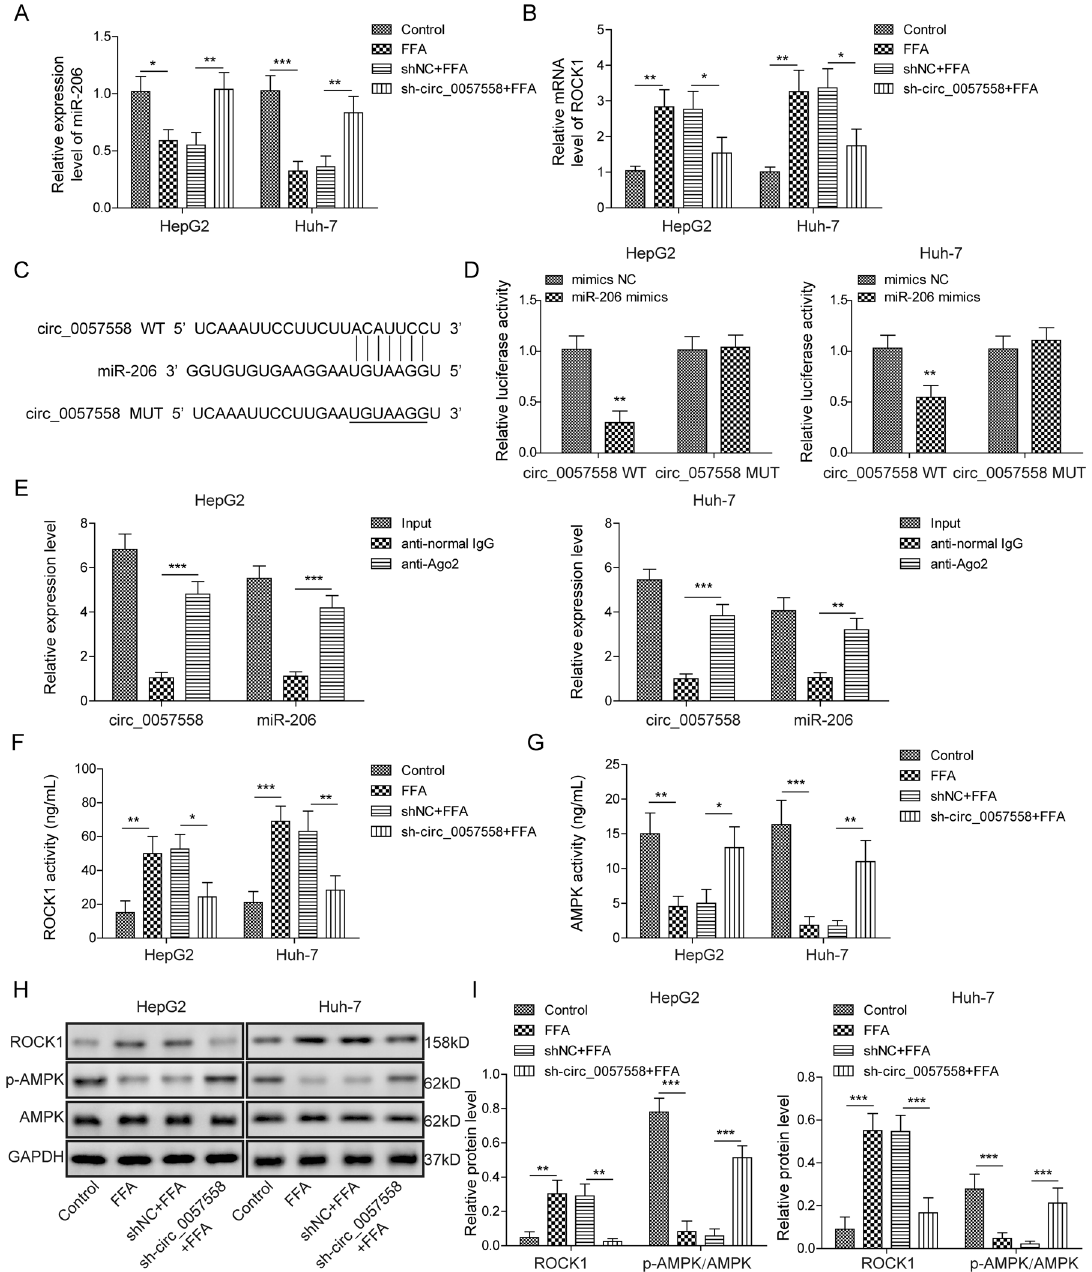
Fig. 6 Circ_0057558 inhibited AMPK signaling via targeting miR-206. A miR-206 levels in cells with the transfection of sh-circ_0057558 or sh-NC following FFA or control treatment. B ROCK1 mRNA levels in cells with the transfection of sh-circ_0057558 or sh-NC following FFA or control treatment. C Binding sites between the miR-206 and circ_0057558. D Relative luciferase activity of circ_0057558-WT and circ_0057558- MUT in cells with the transfection of miR-206 mimics or NC. E circ_0057558 and miR-206 levels following immunoprecipitation with anti-AGO2 or anti-IgG. F , G ROCK1/AMPK activities in cells with the transfection of sh-circ_0057558 or sh-NC following FFA or control treatment. H Protein levels of ROCK1 and p-AMPK in cells with the transfection of sh-circ_0057558 or sh-NC following FFA or control treatment. I Quanti fi cations of H . * p < 0.05, ** p < 0.01, and *** p <